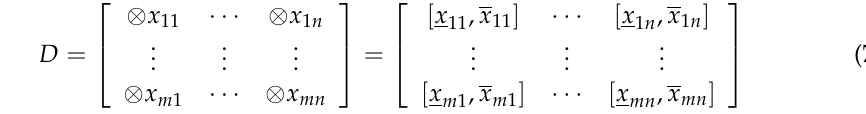
Table 1. The linguistic scales used in G-AHP. Importance Value Linguistics Scales Grey Numbers [ x , x ] 1 Equivalent importance (EI) [1, 2] 3 Medium importance (MI) [2, 4] 5 Strong importance (SI) [4, 6] 7 Very Strong importance (VSI) [6, 8] 9 Extreme importance (EMI) [8,